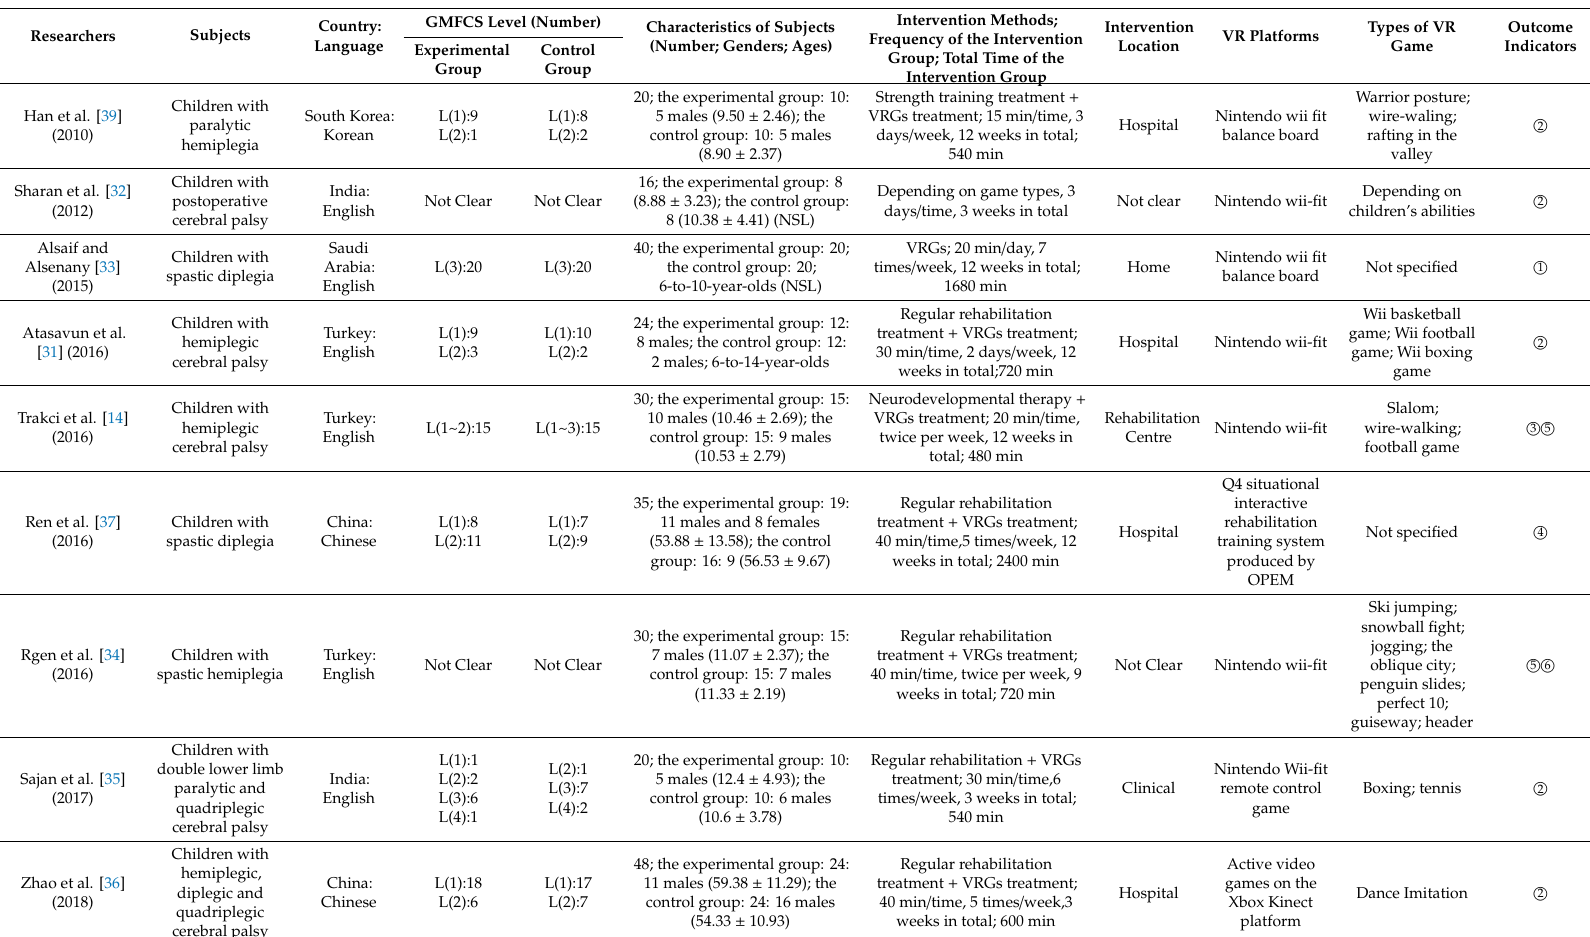
Table 1. List of basic characteristics of the included